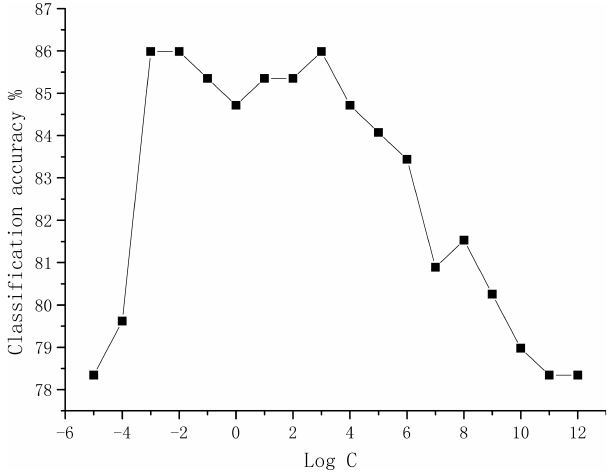
Fig. 3. Dependence of classi¯cation accuracy on parameter C using a linear SVM. The base of log C is 2.